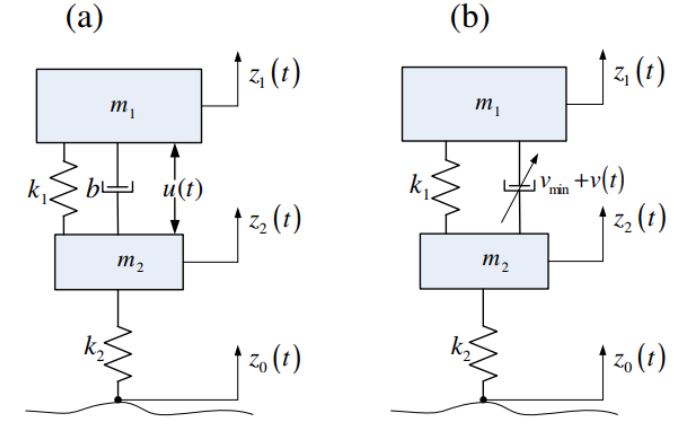
Figure 2. Mathematical quarter-car models with ( a ) active suspension system and ( b ) semi-active suspension